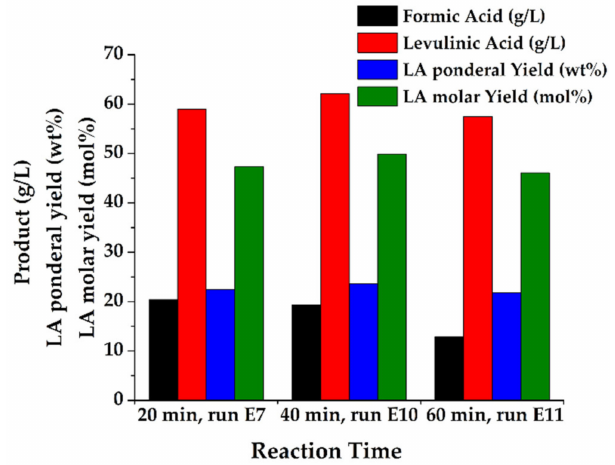
Figure 2. Hydrolysis experiments on wet E cardoon sample at different reaction times. Experimental conditions: 190 ◦ C, HCl as catalyst (1.4 wt%), sub/cat = 2.0 mol/mol, biomass loading = 20 wt% on